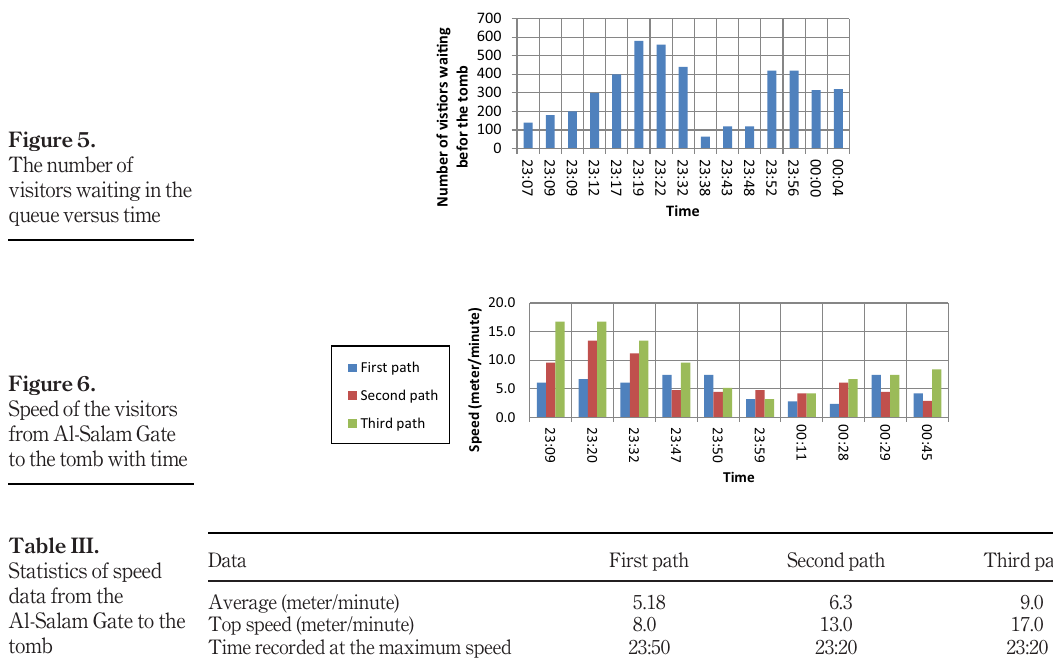
Table III. Statistics of speed data from the Al-Salam Gate to the